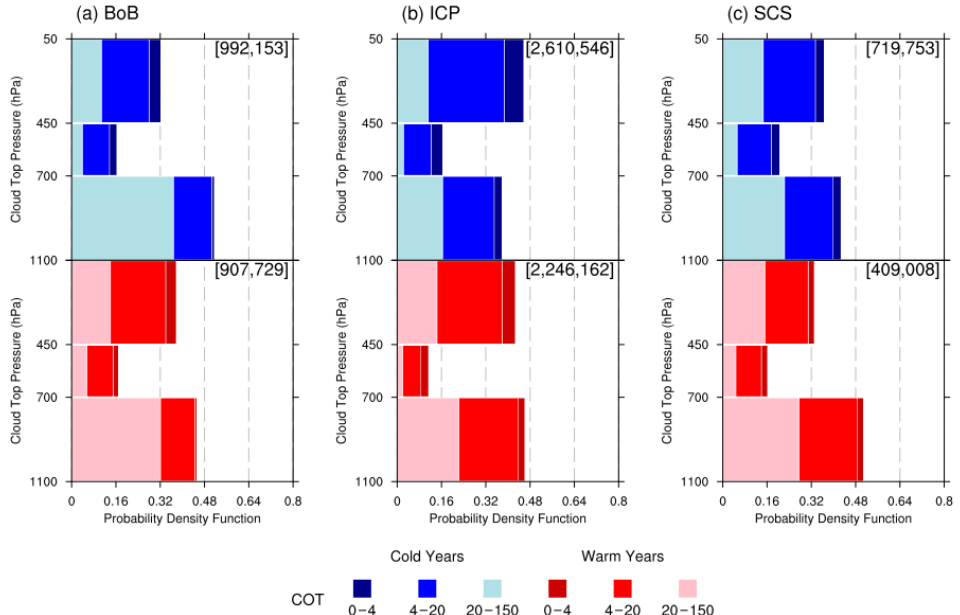
Figure 9. The marginal probabilities of CTP with respect to three categories of COT compiled over the ( a ) BoB, ( b ) ICP, and ( c ) SCS regions, collected from May of cold (blue tone) and warm (red tone) years. The BoB, ICP, and SCS regions are indicated in Figure 8b. The COT is for liquid water cloud in the daytime and is a dimensionless quantity, CTP is in hPa. The numbers in square brackets are the total counts for these statistical periods. The marginal probabilities of CTP are derived from the joint histograms of COT binned against CTP and are displayed as stacked histograms with probability as the x -axis and CTP as the y -axis. The COT is grouped into three categories of newly aggregated bins from the original COT histogram bins: 0 – 4, 4 – 20, and 20 – 150, whereas the CTP are grouped into three categories of newly aggregated bins from the original CTP histogram bins: 50 – 450, 440 – 700, and 700 – 1100 hPa. For each plot panel, three sets of the marginal probabilities of CTP are obtained by integrating the joint probability (relative frequency) over the specific ranges of the aggregated bins from the three corresponding COT categories, respectively.